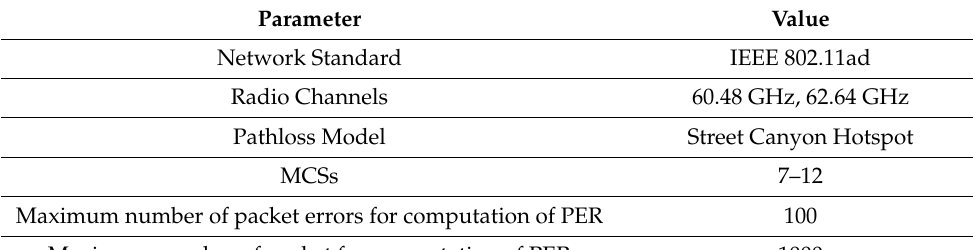
Figure 4. Network Layout. Table 2. Simulation Parameters [32–34].